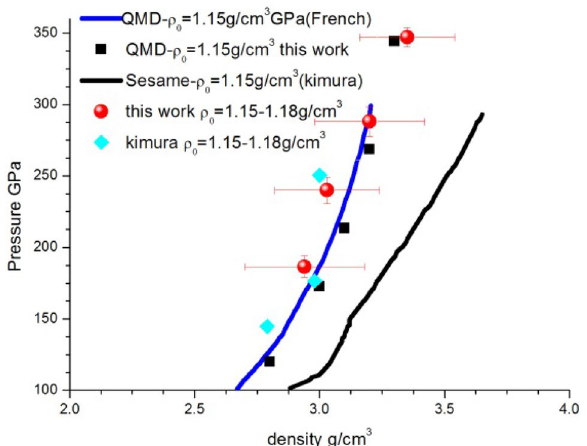
Figure 4. Density and pressure relations for shocked water with initial density of 1.15 g/cm3. Our experiment data in red circle and Kimura 15 in cyan diamond, QMD EOS model (kimura’s in blue line, this work in black square) and Sesame Model in black line.